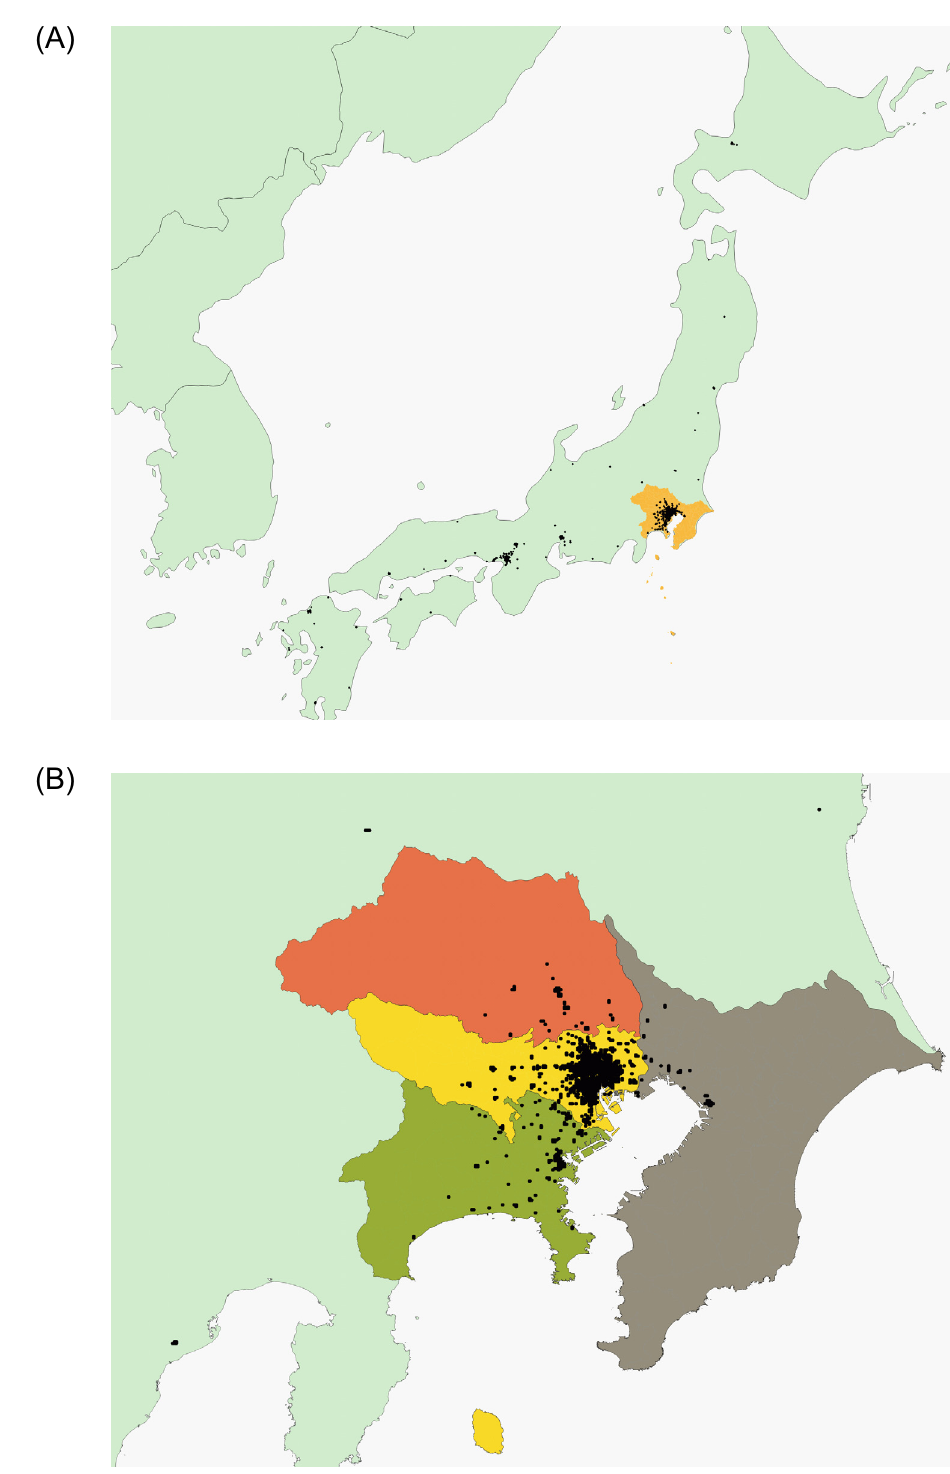
Fig 5. Location of high-density places. (A) Black dots in the map represent grid cells in which the average population at 10:00 a.m. on Thursdays in November 2019 exceeded 4,000. The yellow area represents Tokyo MA. (B) We analyze four prefectures: The deep green is Kanagawa prefecture, the yellow is Tokyo prefecture, The orange is Saitama prefecture, and the gray is Chiba prefecture. We obtained Figs 5A and 5B from Natural Earth and National Land Information Division, National Spatial Planning and Regional Policy Bureau, Ministry of Land, Infrastructure, Transport and Tourism of Japan.